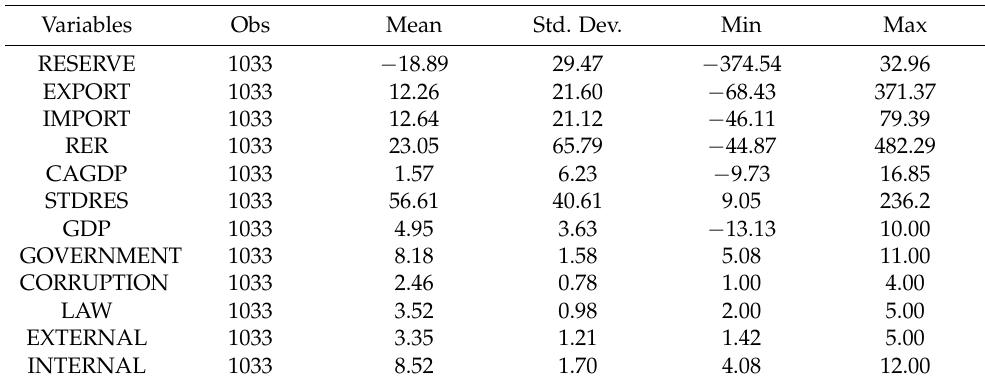
Table Panel B: Summary of descriptive statistics for the tranquil period, 1992–2011